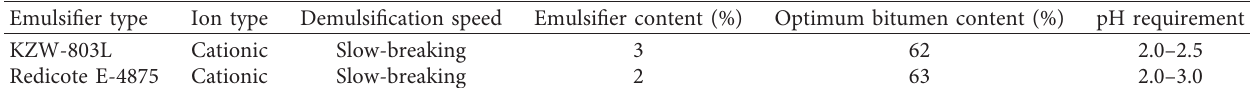
Table 2: Technical information on the emulsifiers.